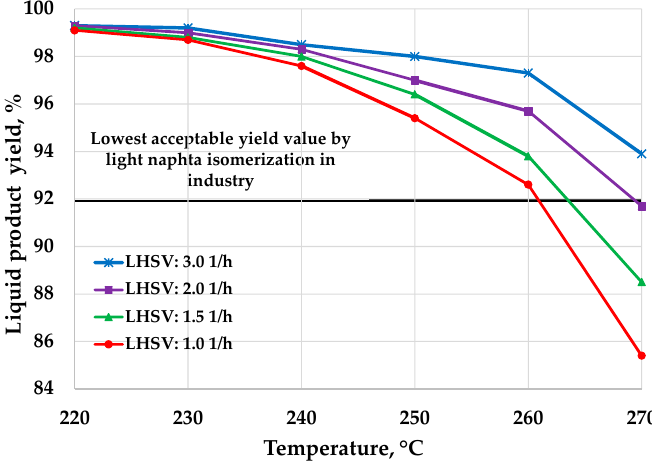
Figure 5. ChangeofliquidproductyieldsasafunctionoftemperatureandLHSV(catalyst:Pt / H-Mordenite, Figure 5. Change of liquid product yields as a function of temperature and LHSV (catalyst: Pt/H- feedstock: Mordenite, feedstock: “B”).